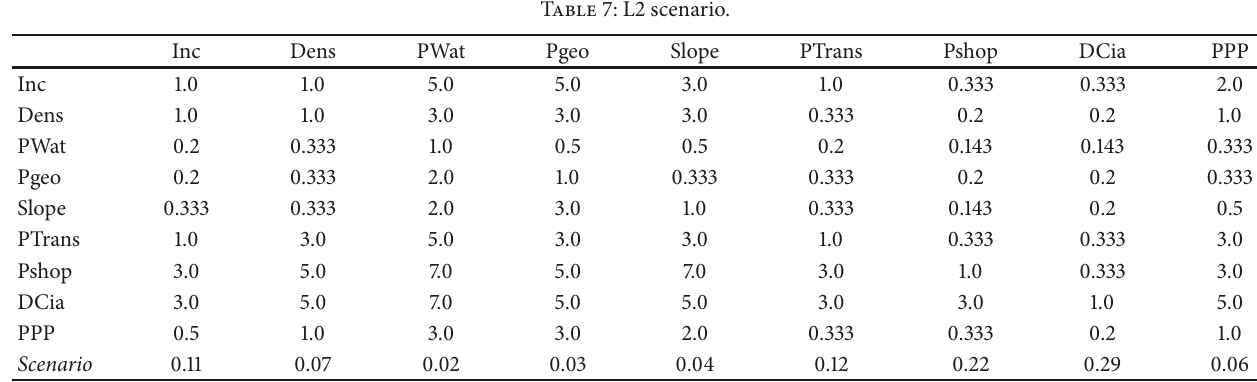
Table 7: L2 scenario.